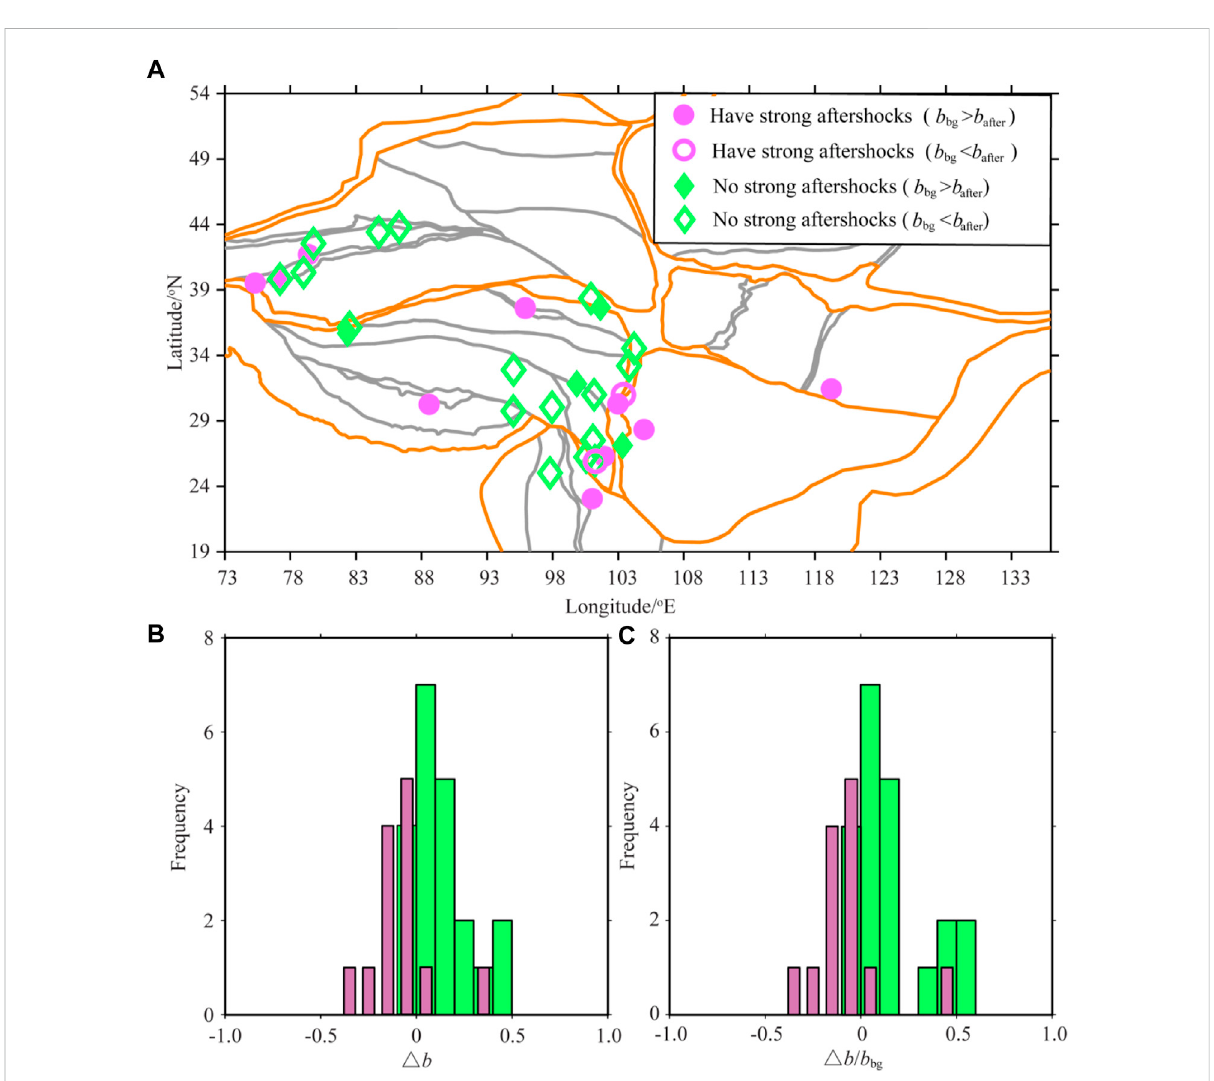
FIGURE 5 Distribution characteristics of 34 M S ≥ 6.0 earthquake sequences in the China continent. (A) Distribution of the epicenters of the main shocks. They are classi fi ed according to the presence or absence of strong aftershocks of M ≥ 5.0 and the relative size relationship between b- values of background events ( b bg ) and that of aftershocks ( b after ), and indicated by different colors. The brown represents the boundary line of the primary plate,andthegrayrepresentstheboundarylineofthesecondaryplate. (B) Statisticaldistributionofdifferencesbetweenbackgroundevents b bg and aftershock b after , △ b. (C) Statistical relationship of △ b / b bg. In (B,C) , light red represents the earthquake sequences having strong aftershocks of M ≥ 5.0, and light green represents the earthquake sequences having no strong aftershocks of M ≥